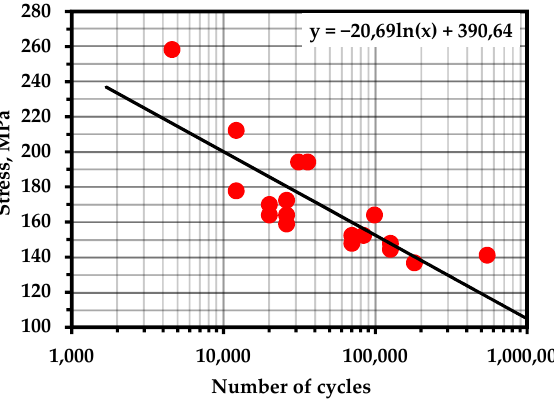
Figure A10. S–N Curve—Steel AISI 304L (Temperature—700 К ; frequency—40 Hz; R = − 1) [103].